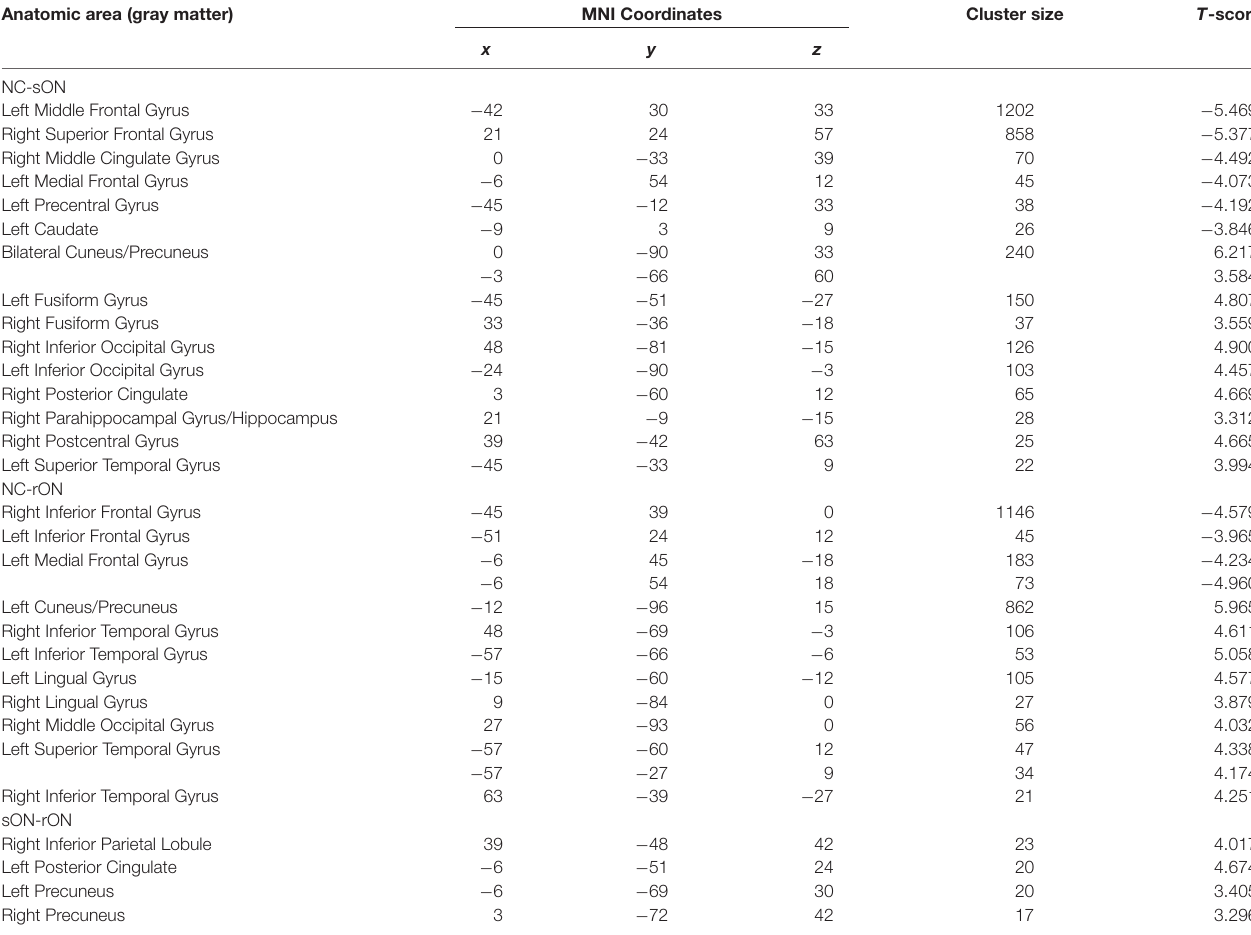
TABLE 2 | Brain areas showing significant amplitude of low-frequency fluctuation (ALFF) differences among the single optic neuritis (sON), relapsing optic neuritis (rON) and normal control groups (corrected p < 0.01 using AlphaSim). Anatomic area (gray matter) MNI Coordinates Cluster size